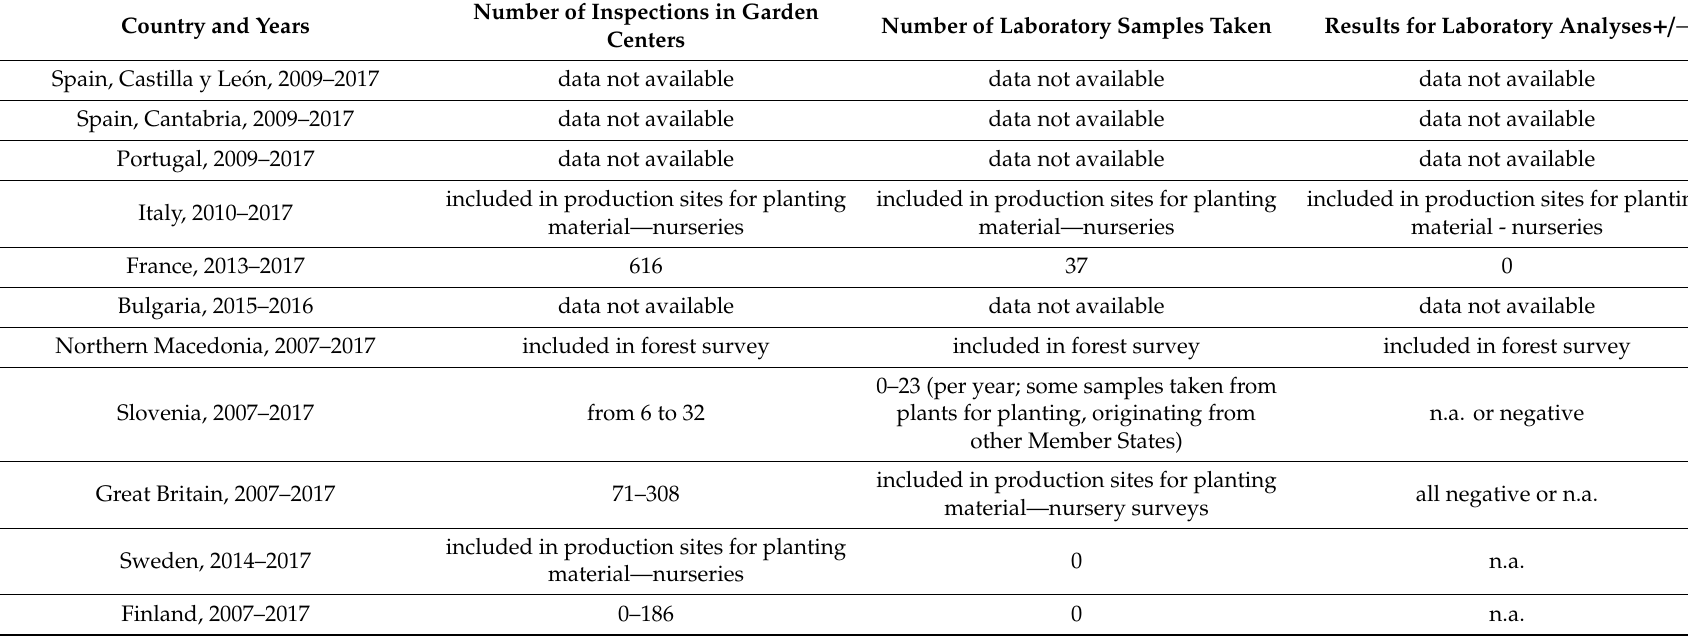
Table 4. Sampling approaches in garden centers. The data is based on the annual reports submitted to the European Commission by the